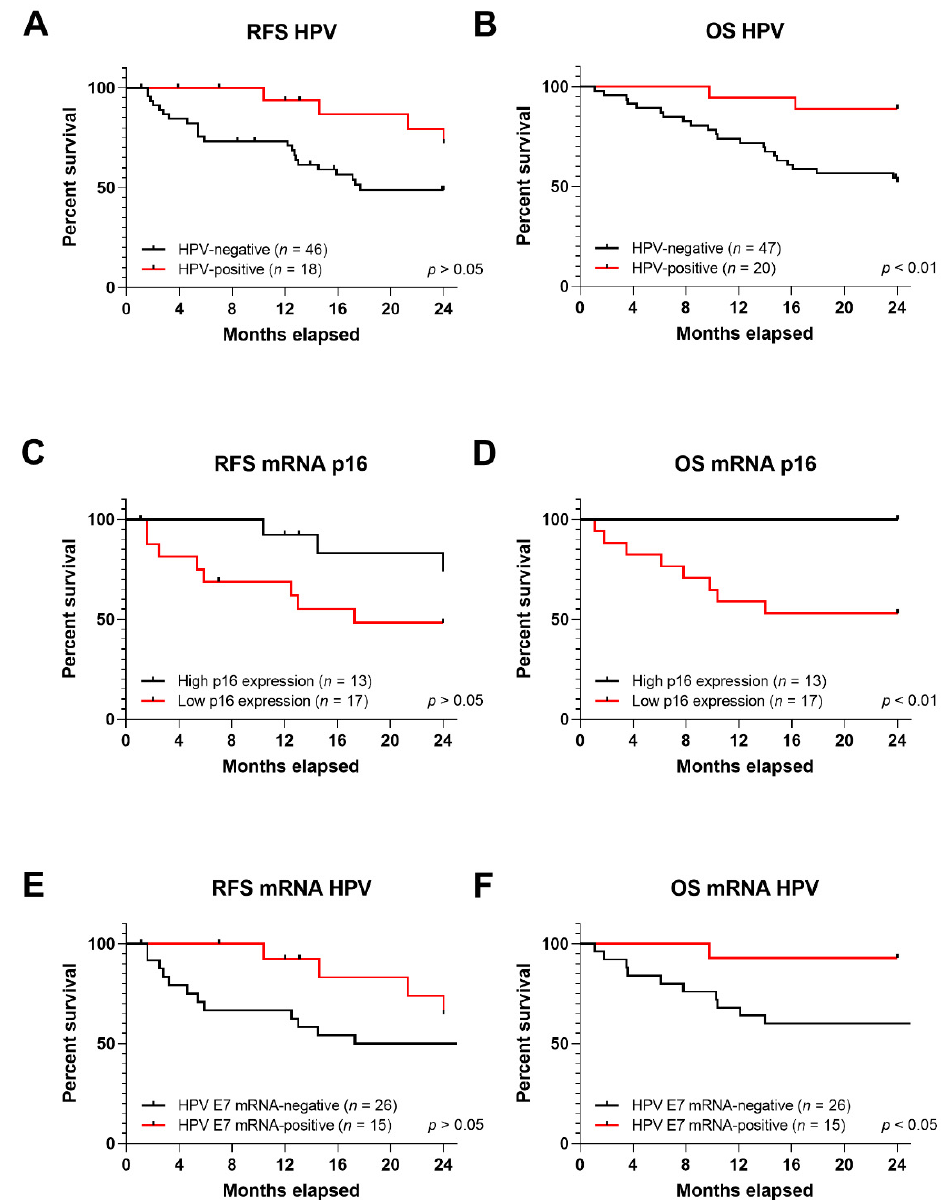
Figure 3. Kaplan-Meier (KM) curves for RFS and OS in HNSCC; KM curves for ( A ) RFS and ( B ) OS for HPV DNA presence in HNSCC tumor samples; KM curves for ( C ) RFS and ( D ) OS for p16 over- or under-expression in HNSCC samples; KM curves for ( E ) RFS and ( F ) OS for HPV E7 mRNA expression in HNSCC tumor samples. Statistical significance was indicated as p < 0.01 or p < 0.05.